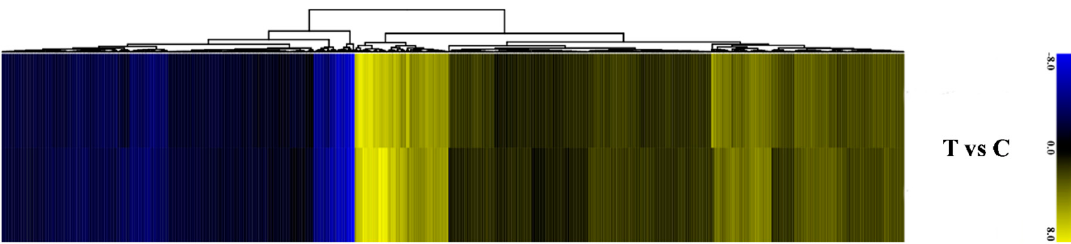
Figure 5. Hierarchical clustering analysis of DEGs and DEPs based on transcriptomic and proteomic data. The heat map is linked by a dendrogram representing a clustering of transcriptomic data or proteomic data (left side). The color code is as follows: blue indicates down-regulated transcripts or proteins; yellow indicates up-regulated transcripts or proteins; black indicates unchanged transcripts or proteins. Each row represents the log2 (treated/C) of a gene or protein. The color scale of the heat map ranges from saturated blue (value, − 8.0) to saturated yellow (value, 8.0) in the natural logarithmic scale.